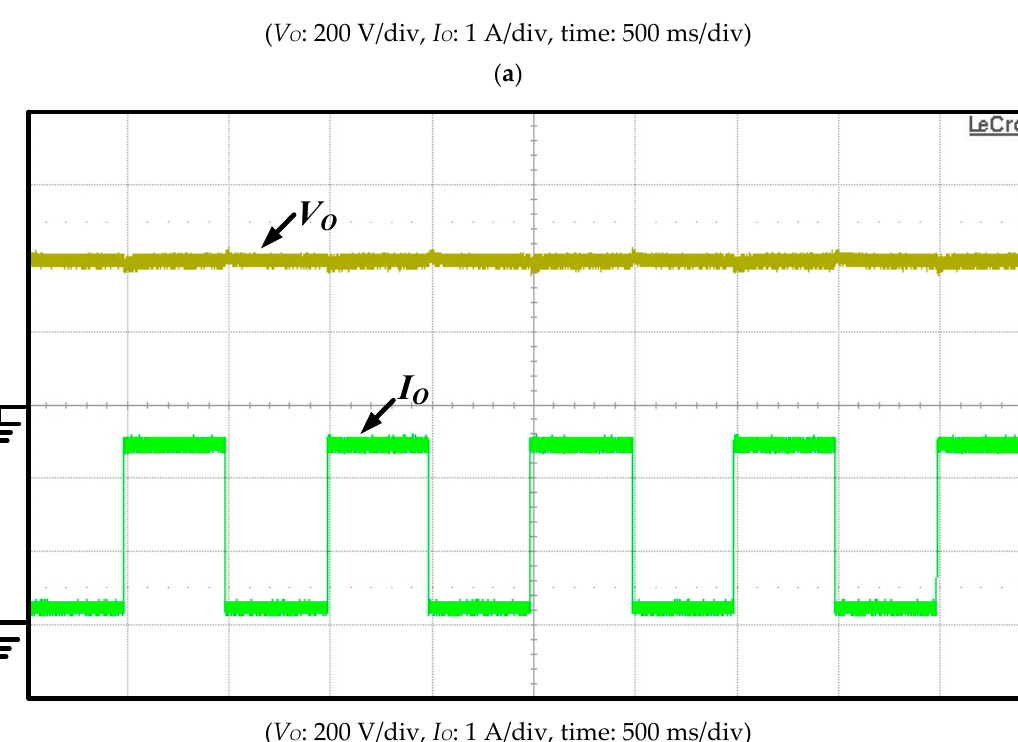
Figure 11. Measured output voltage V o and current I o waveforms of step-load changes between 10% and 100% of full-load conditions with duty ratio of 50% and repetitive period of 1s: ( a ) under ac110V of input voltage, and ( b ) under ac220V of input voltage.